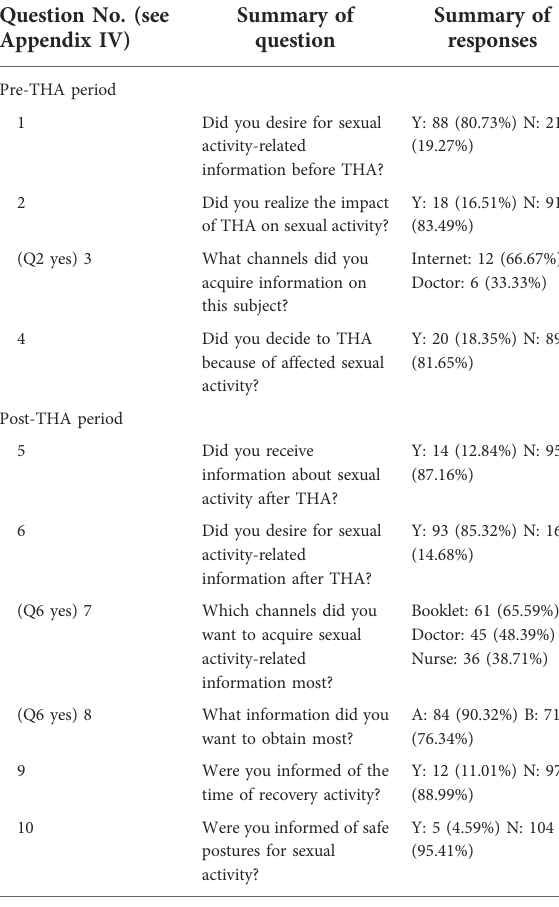
before and after THA. Question No.